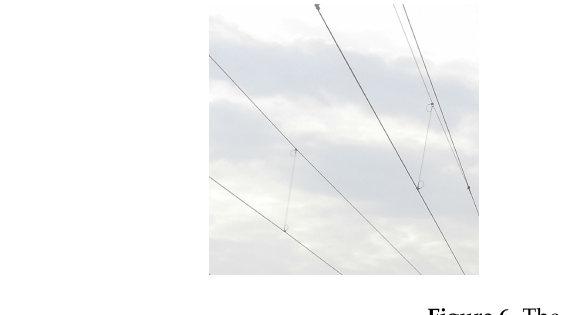
Figure 6. The wire scenes.